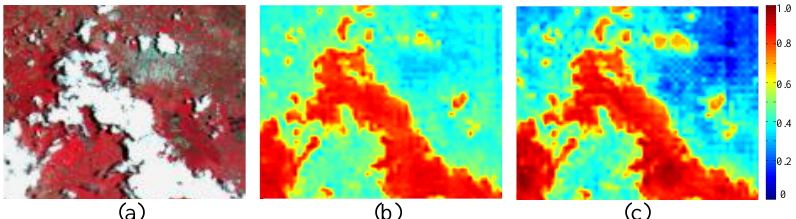
Figure 6. Experiment results on an unlabeled remote sensing image. ( a ) input GF-1 WFV image; ( b ) un-applied domain adaptation result, and ( c ) applied domain adaptation result.